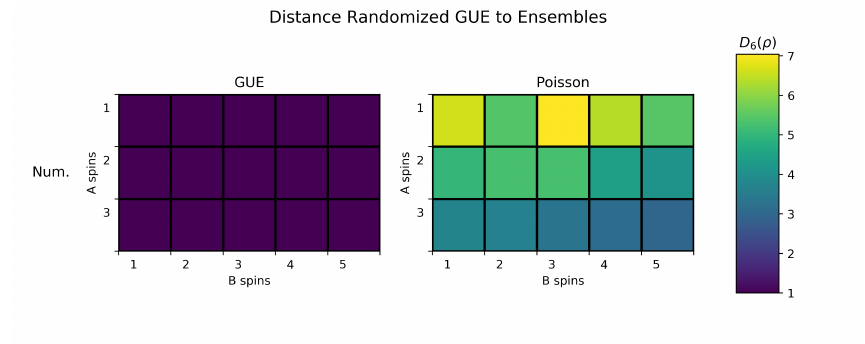
Figure 20: Left: Distance of subsystem dynamics of the numerical GUE to the analytical GUE, normalized to itself, Right: Distance of numerical GUE to the analytical Poisson distribution, normalized to the distance of the numerical Exponential Distribution to the analytical Poisson. These values are given for different number of subsystem and bath spins.